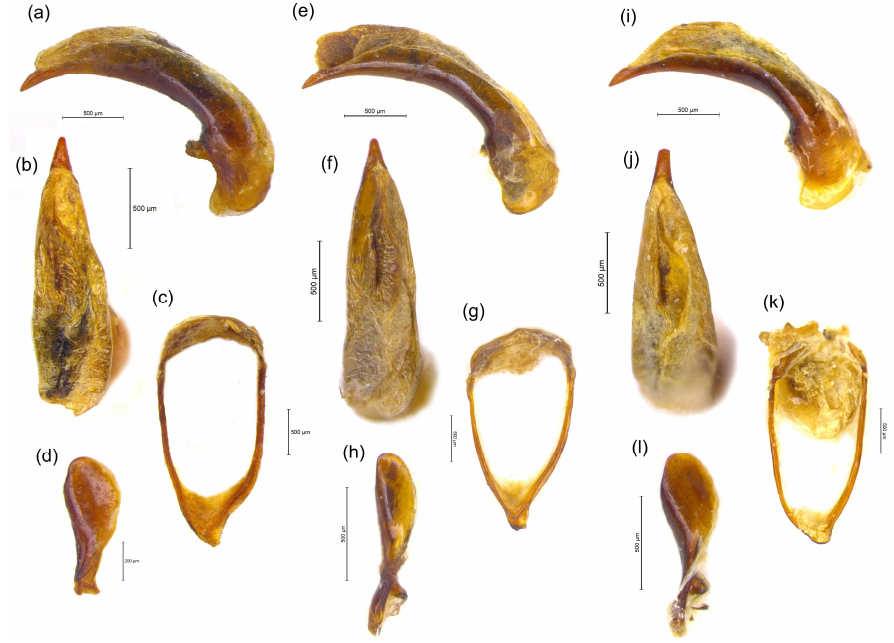
Figure 13. Male genitalia: The median lobe of the aedeagus is in lateral and dorsal view, IX invaginated segment and right paramere of: ( a – d ) P. occitanus n. sp .; ( e – h ) P. peirolerii ; ( i – l ) P. maritimus n. sp.